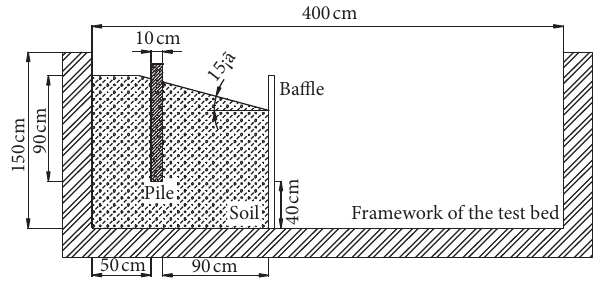
Figure 2: The profile chart under 15 °